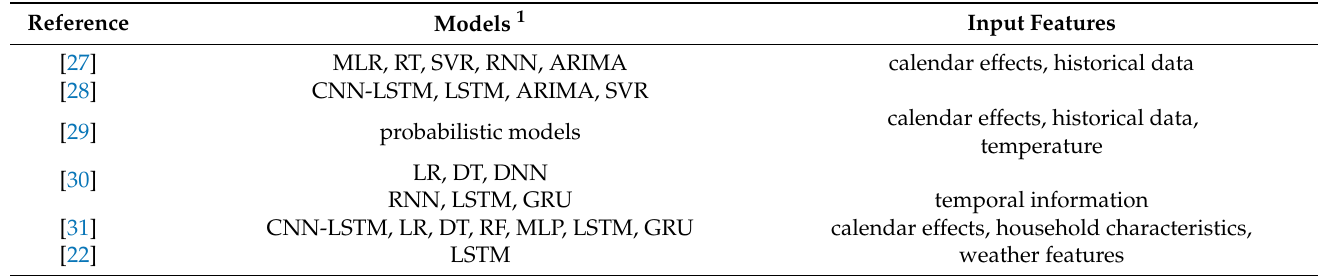
Table 2. Techniques applied in the forecasting of household electricity